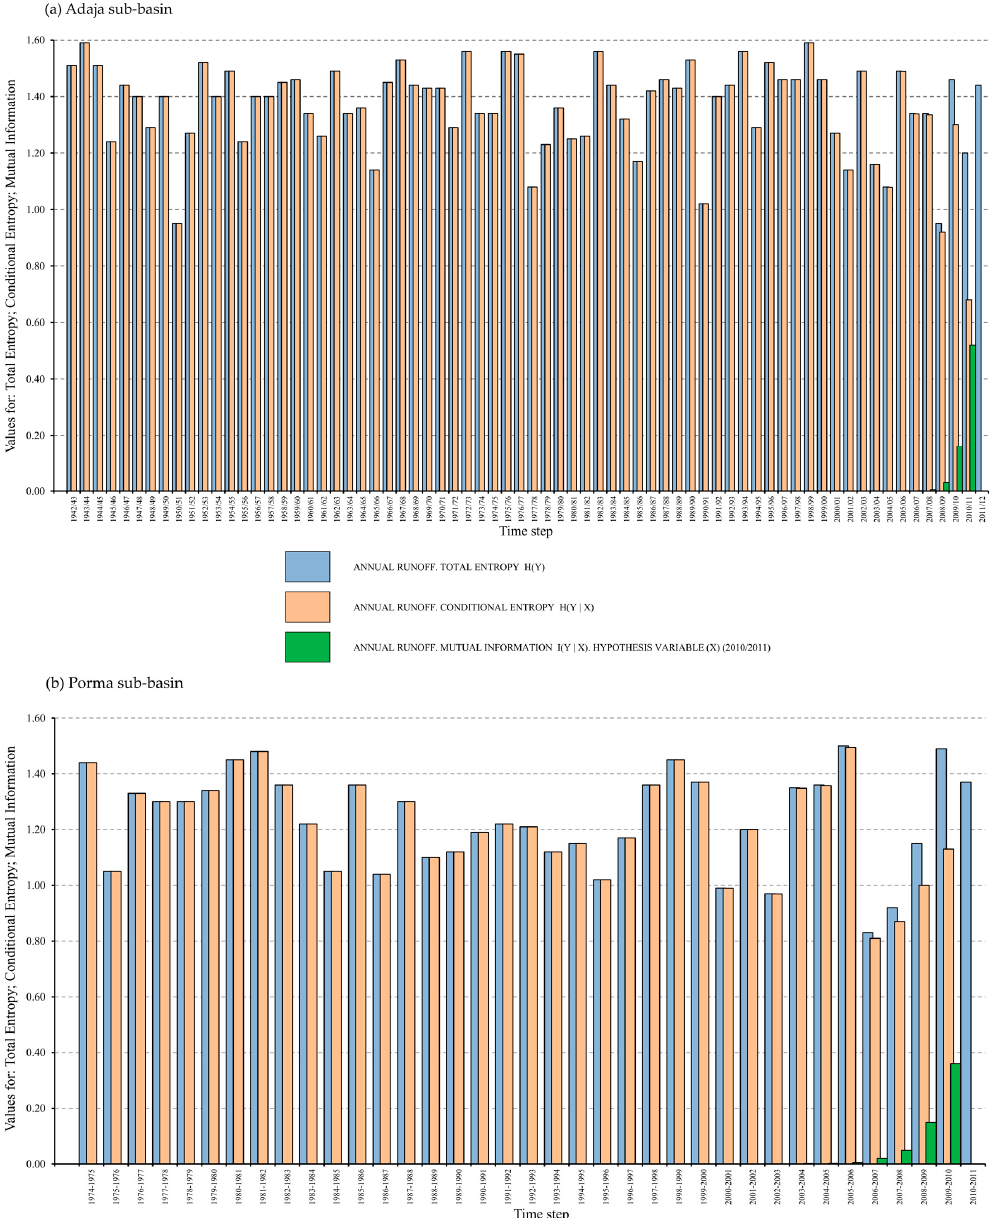
Figure 9. Sensitivity analysis of the BN model and analysis: Entropy, Conditional Entropy and Mutual Information. ( a ) Adaja sub ‐ basin; ( b ) Porma sub ‐ basin.